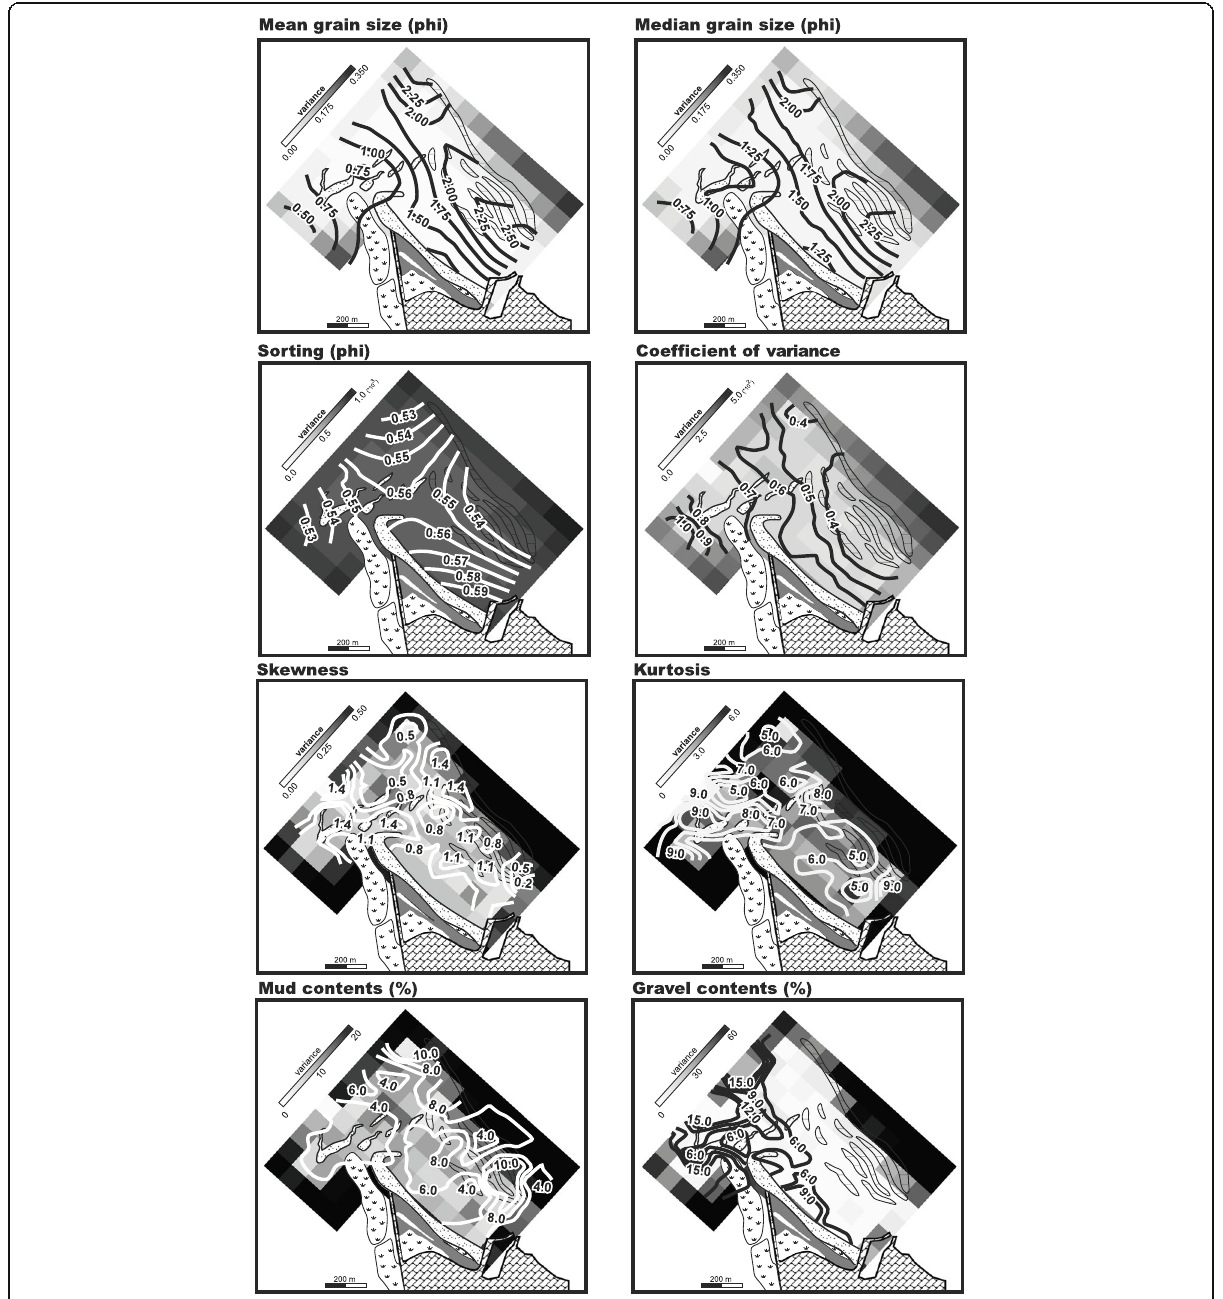
Fig. 7 Contour maps of grain-size parameters interpolated by kriging over raster maps of the estimation variance. The relatively lighter gray color in each raster map indicates a higher precision of interpolation. The absolute values of the estimation variance are not meaningful because these values depend on the values of the variables and the shapes of the